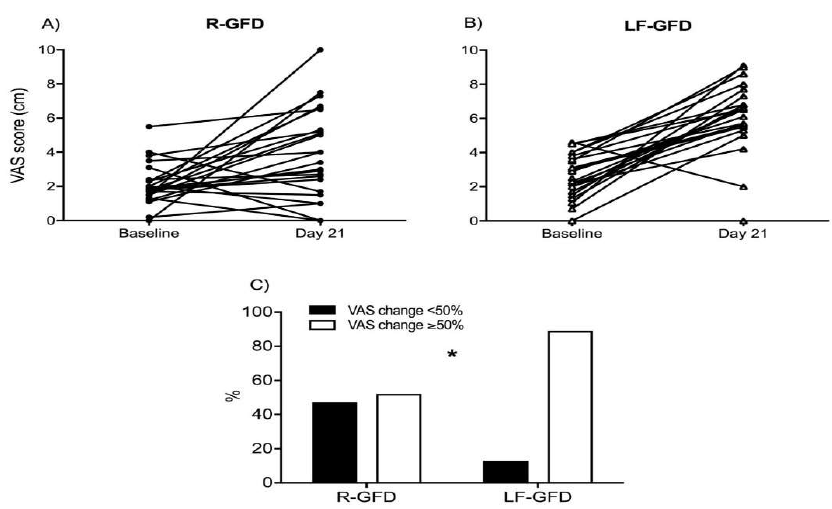
Figure 3. Change in the VAS of well-being between the baseline and day 21 from intervention. VAS score for overall well-being was evaluated at the baseline and at the end of the intervention period (day 21) for the R-GFD ( A ) and LF-GFD ( B ) groups; the magnitude of change in well-being perception ( C ) was calculated by estimating the number of patients (shown in percentage for each group) with a change in VAS score greater than or equal to 50% of the baseline value. Data are individual values at both time points. R-GFD: regular gluten-free diet; LF-GFD: low-FODMAP gluten-free diet; VAS: visual analogue scale. * p = 0.03 Fisher´s exact test.